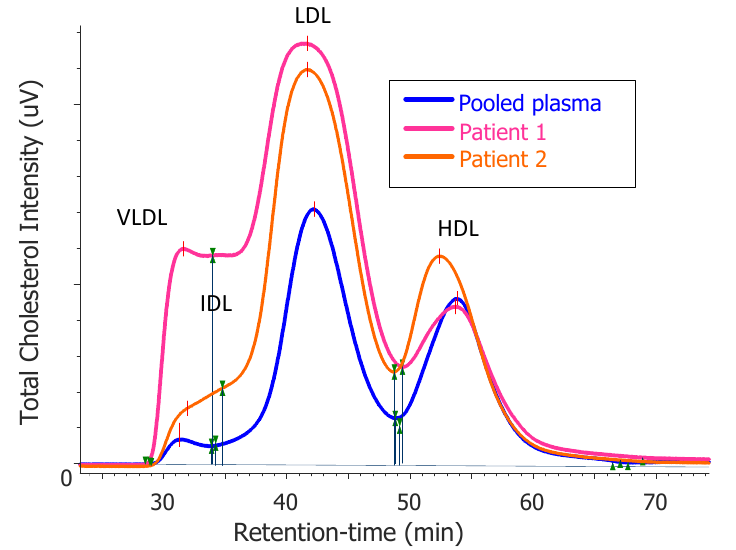
Figure 1. Results of the total cholesterol distribution in plasma after fast protein liquid chromatography (FPLC) profiling from patient 1 and patient 2 compared with that of pooled plasma from healthy subjects. The elution of the main lipoprotein classes is indicated for very-low-density lipoprotein (VLDL), intermediate-density lipoprotein (IDL), low-density lipoprotein (LDL), and high-density lipoprotein (HDL), respectively.